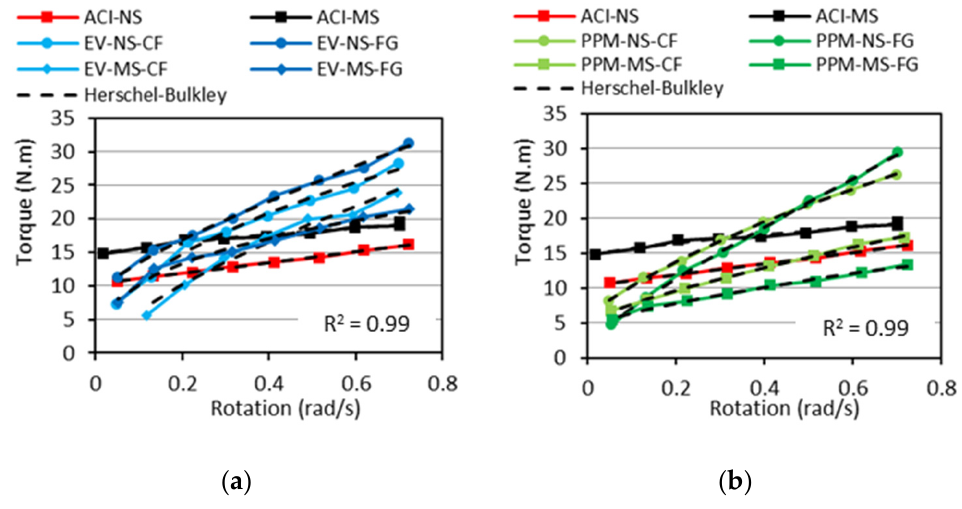
Figure 12. Rheological profiles of ( a ) EV and ( b ) PPM mixes compared to Herschel–Bukley’s model.